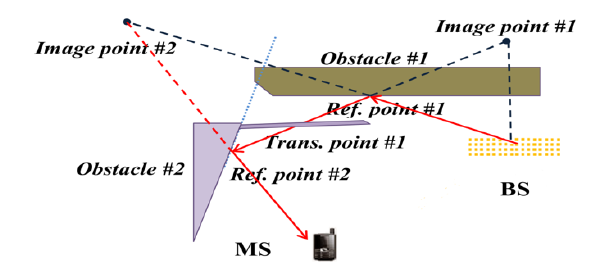
Figure 1. Schematic of ray tracing